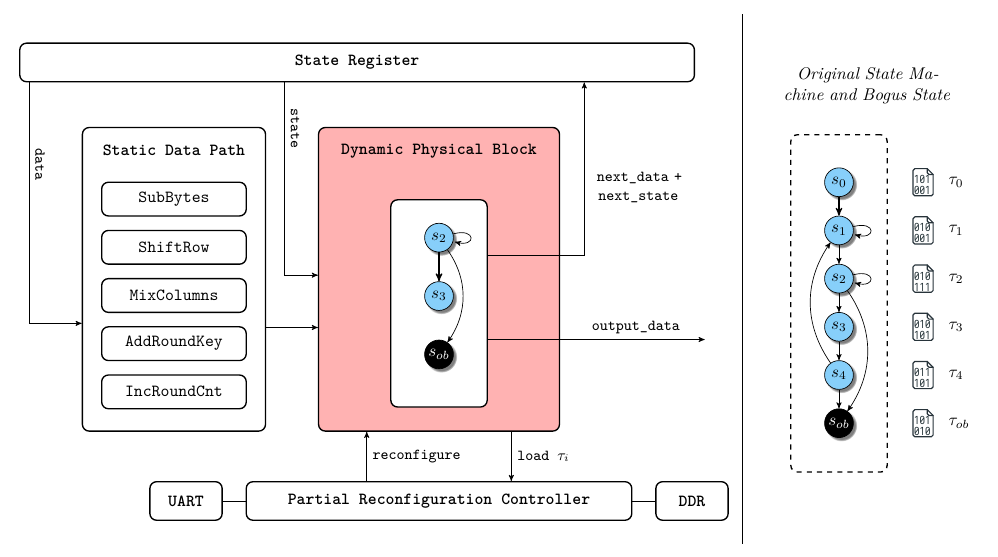
Figure 13: Example: Iterative AES IP core with Hardware Nanomites currently holding the partial design τ 2 . The dynamic physical block (marked in red) takes the current state register value state and data from the static design part as an input and determines the next state and control signals. The circuit updates the round counter, assigns values to the primary output, and triggers partial reconfiguration, if necessary. Note that the state register is managed by the partial reconfiguration controller as a memory-mapped address.